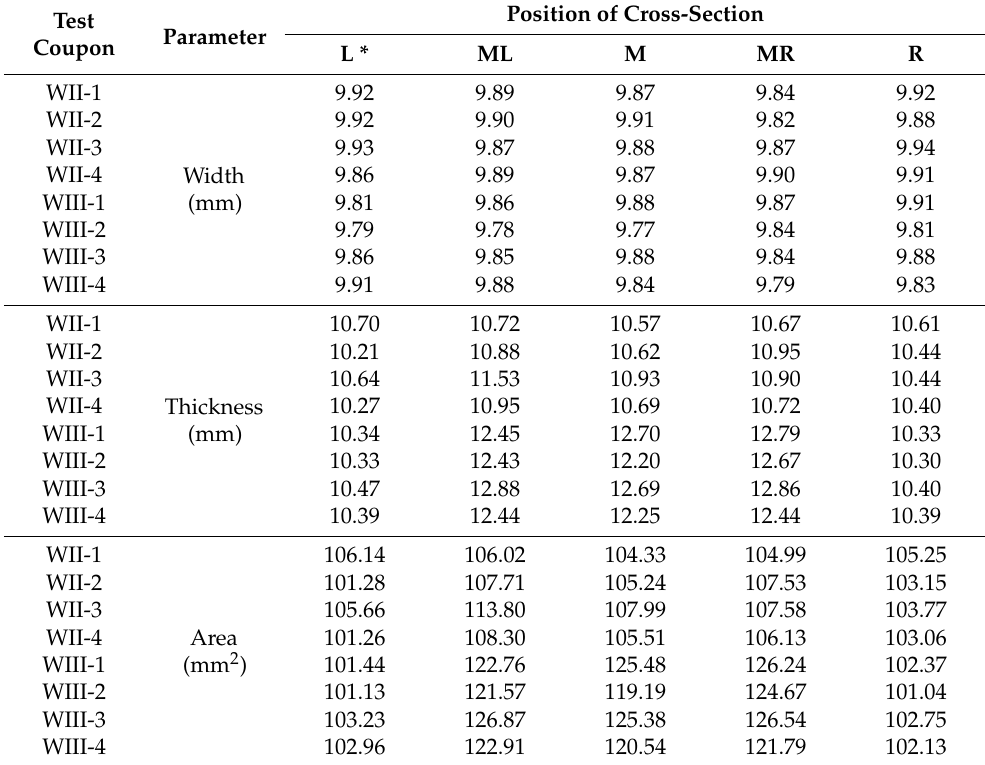
Table 8. Measured geometric dimensions of different coupons.